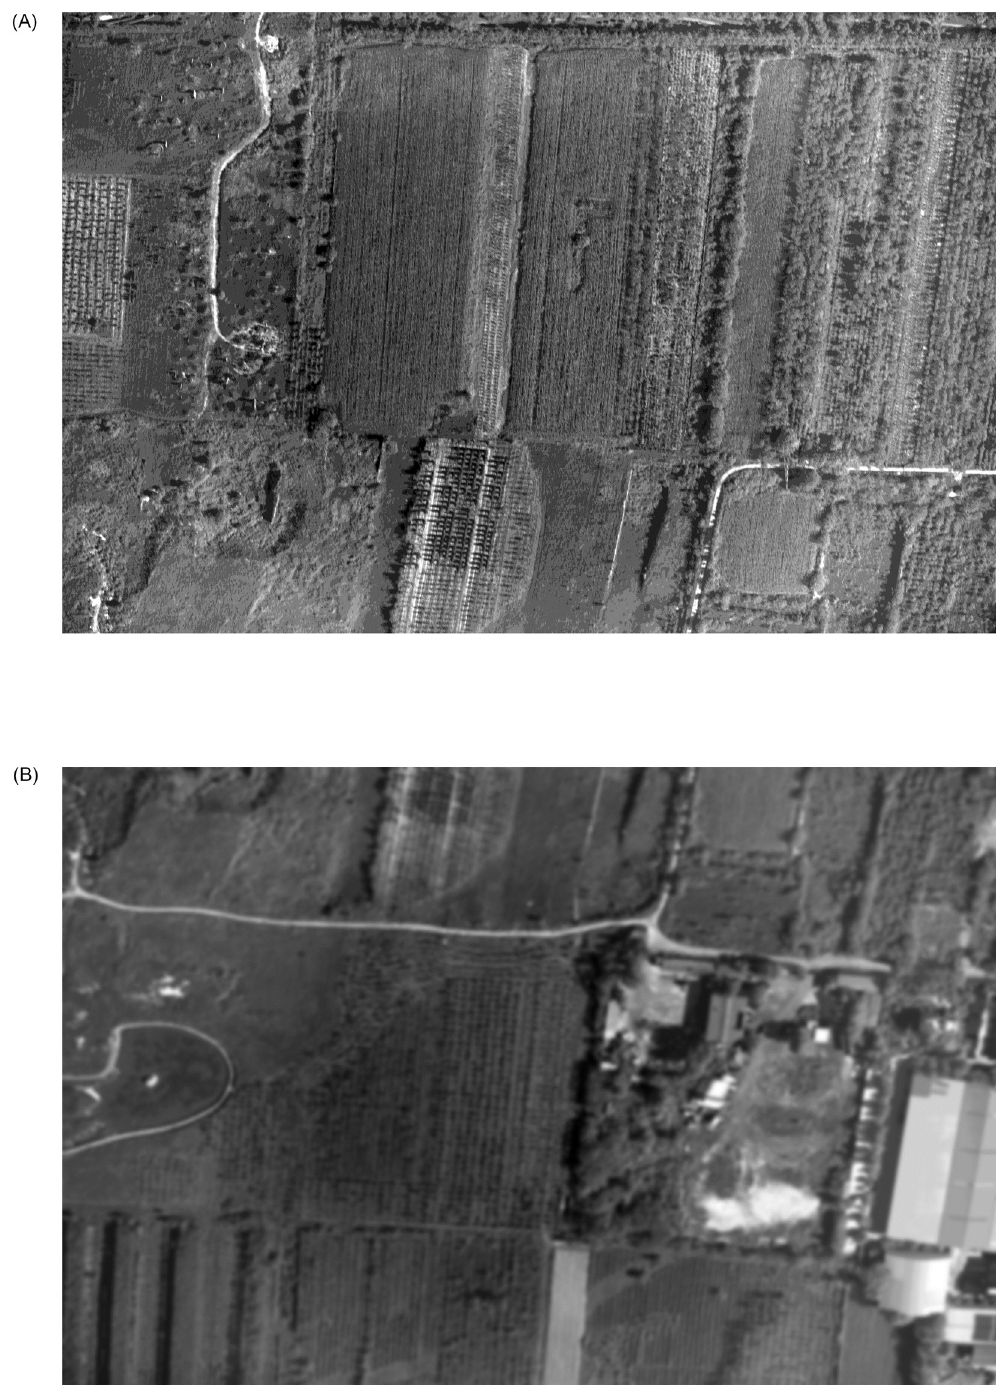
Fig 11. The clear and the blur original aerial remote sensing images.